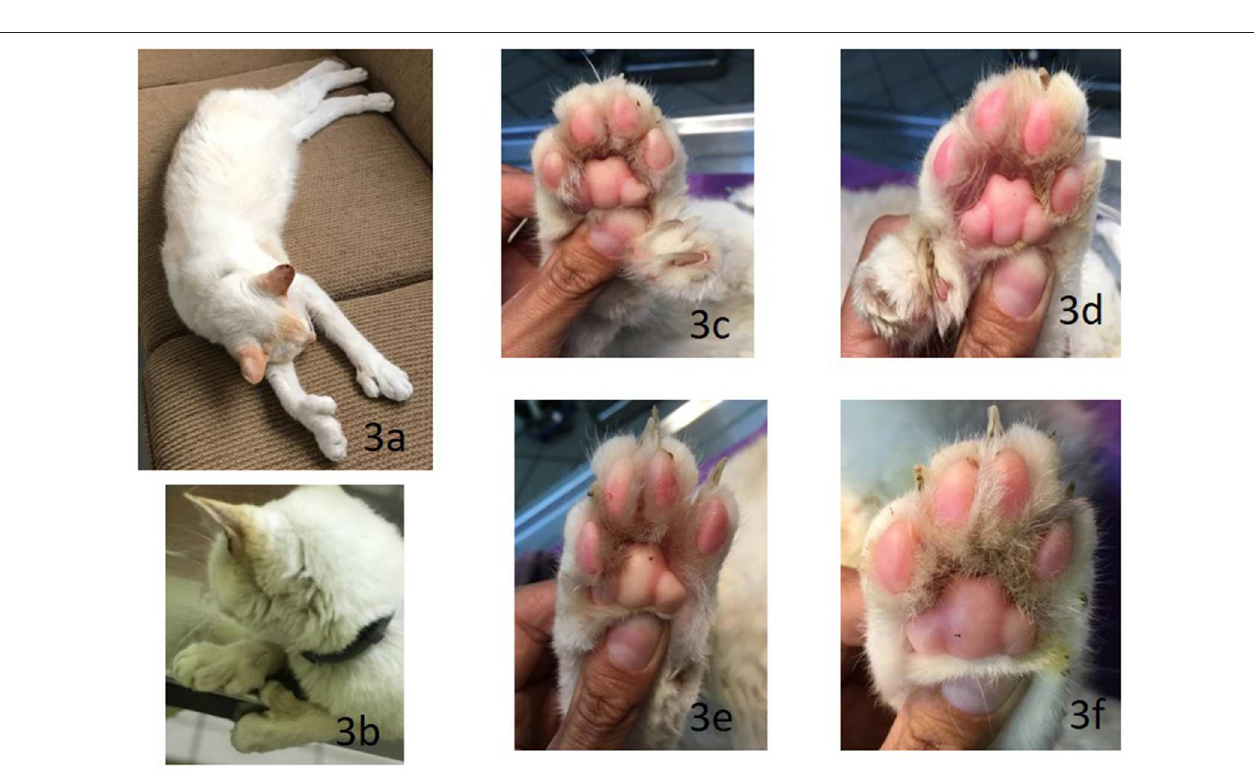
FIGURE 3 | 14-year-old neutered Mexican male cat. (a,b) Head: in an equilateral triangle. Paws: short, of medium bone, strong musculature, medium-sized feet, round, and compact. Polydactyly in the four extremities, (c,d) two accessory fingers preaxially in front and (e,f) one in the back.